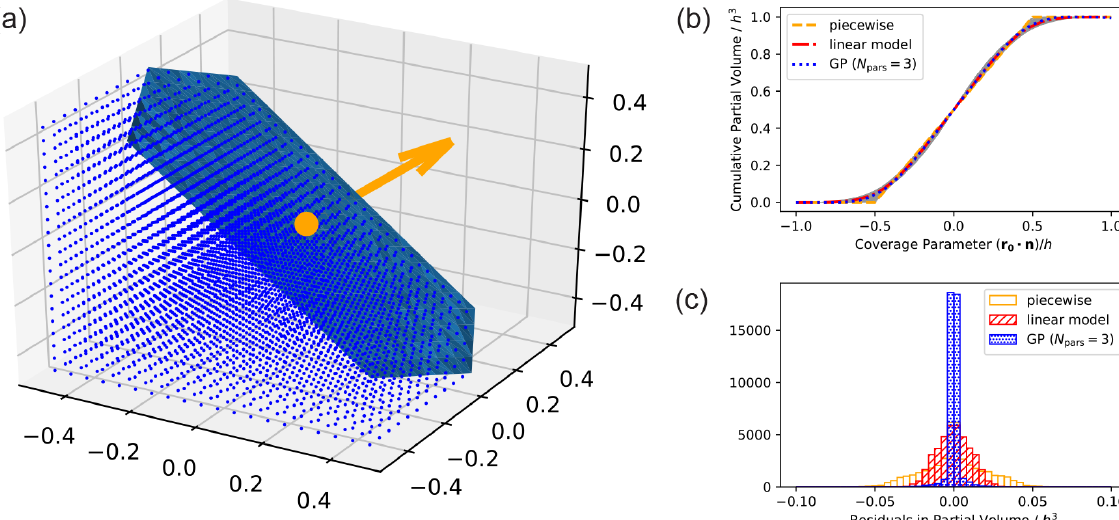
Figure 3. (a) Numerical approach to calculating partial volumes. The interface is approximated by a plane running through the voxel. A cloud of points is generated in a regular grid, and the partial volume is then the fraction of these points that satisfy u ⊥ = ( r − r 0 ) · n /h = 0, where r 0 = (r x ,r y ,r z ) 0 is a point on the interface and n = (n x ,n y ,n z ) is a unit normal vector. (b) Regression models for fast evaluation of partial volumes using data generated from the approximate numerical scheme (gray curves): a piecewise linear interpolation over u ⊥ (red), a generalized linear model with up to third-order terms (blue), and a Gaussian process that also includes features associated with the orientation of the interface (green). (c) Precision of partial volume models. The piecewise model reaches 2% RMS accuracy. A linear regression reaches 1% accuracy, as does a Gaussian process regression with a single feature u ⊥ . A GP with three features that captures the directionality of the interface with respect to the cube boundaries reaches 0.3%